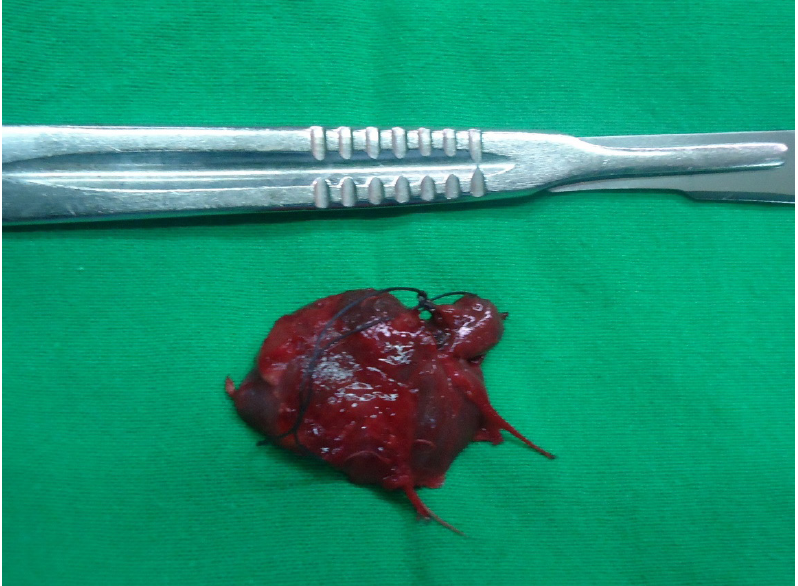
Figure 2: Lesion following surgical